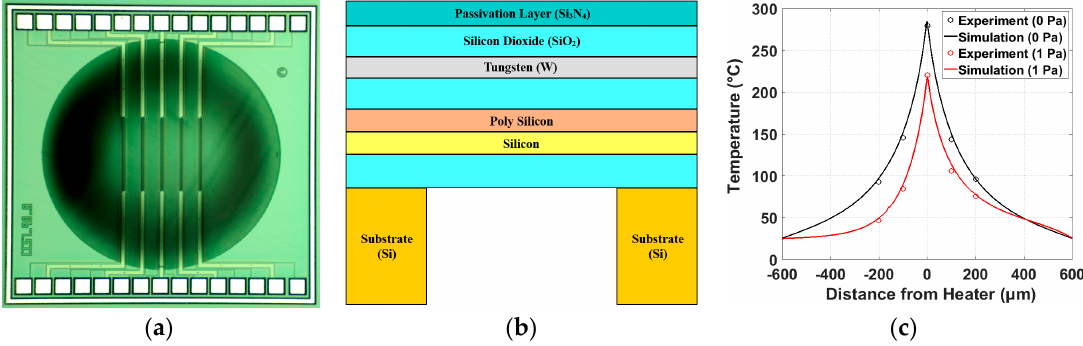
Figure 1. ( a ) Optical micrograph of the fabricated thermoelectronic flow sensor (size: 1.6 mm x 1.6 mm); ( b ) the cross-section of the sensor (not to scale) and ( c ) temperature profile parallel to the direction of flow at no flow (wall shear stress 0 Pa) and flow (wall shear stress 1